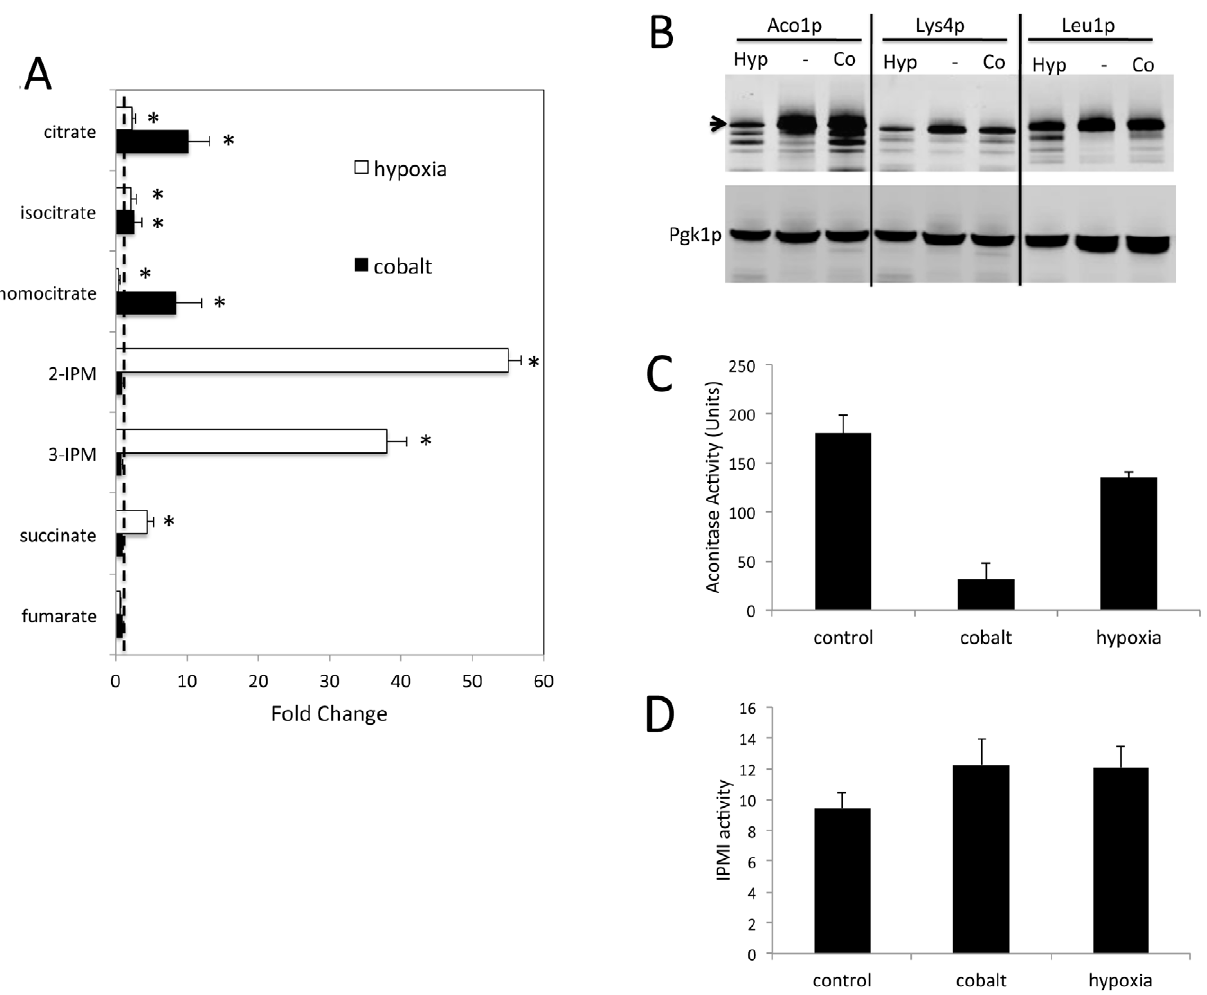
Figure 7. Effects of cobalt on Fe-S enzymes. Cells were grown in minimal medium as in Fig. 1 and were assayed for (A) designated metabolites by GC/MS; (B,C) protein levels and enzymatic activity of indicated Fe-S proteins. A) Levels of select Fe-S enzyme substrates and products presented as fold change over control untreated samples as in Fig. 1B,C. Statistically significant differences over control (P value # 0.05) are designated with asterisks. Dotted line =1.0 value assigned to control. Citrate and isocitrate - substrate and product of Aconitase; homocitrate - homoaconitase substrate; 2-IPM and 3-IPM (isopropyl malate) - substrate and product of IPMI (Leu1p); succinate and fumarate - substrate and product of succinate dehydrogenase. B) Immunoblot analysis of cells expressing TAP tagged versions of Aco1p (aconitase 106 kDa), Lys4p (homoaconitase 96 kDa) and Leu1p (IPMI 106.5 kDa). Results are representative of three (Leu1p), four (Lys4p) and five (Aco1p) experimental trials. C–D) Cell lysates prepared and assayed for aconitase (C) and IPMI (D) activity as described in Materials and Methods. 1 unit of activity is defined as 1 nmole of substrate consumed per min per mg of protein.